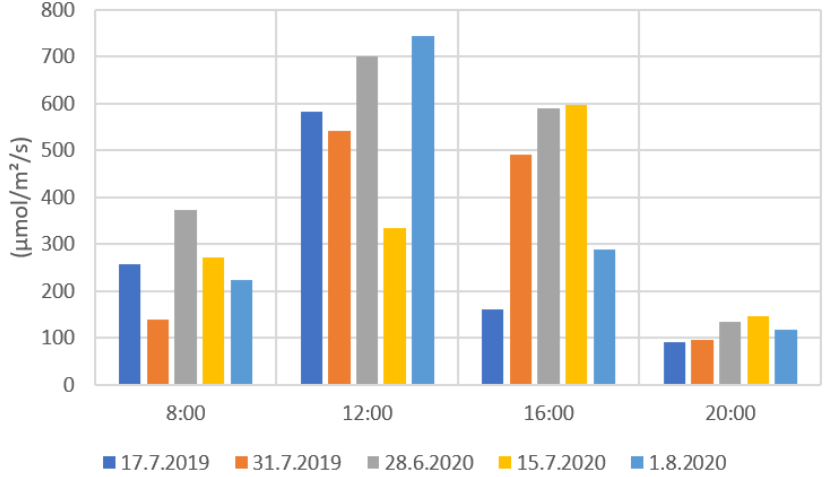
Figure 10. PAR radiation measurement values for each flight date.